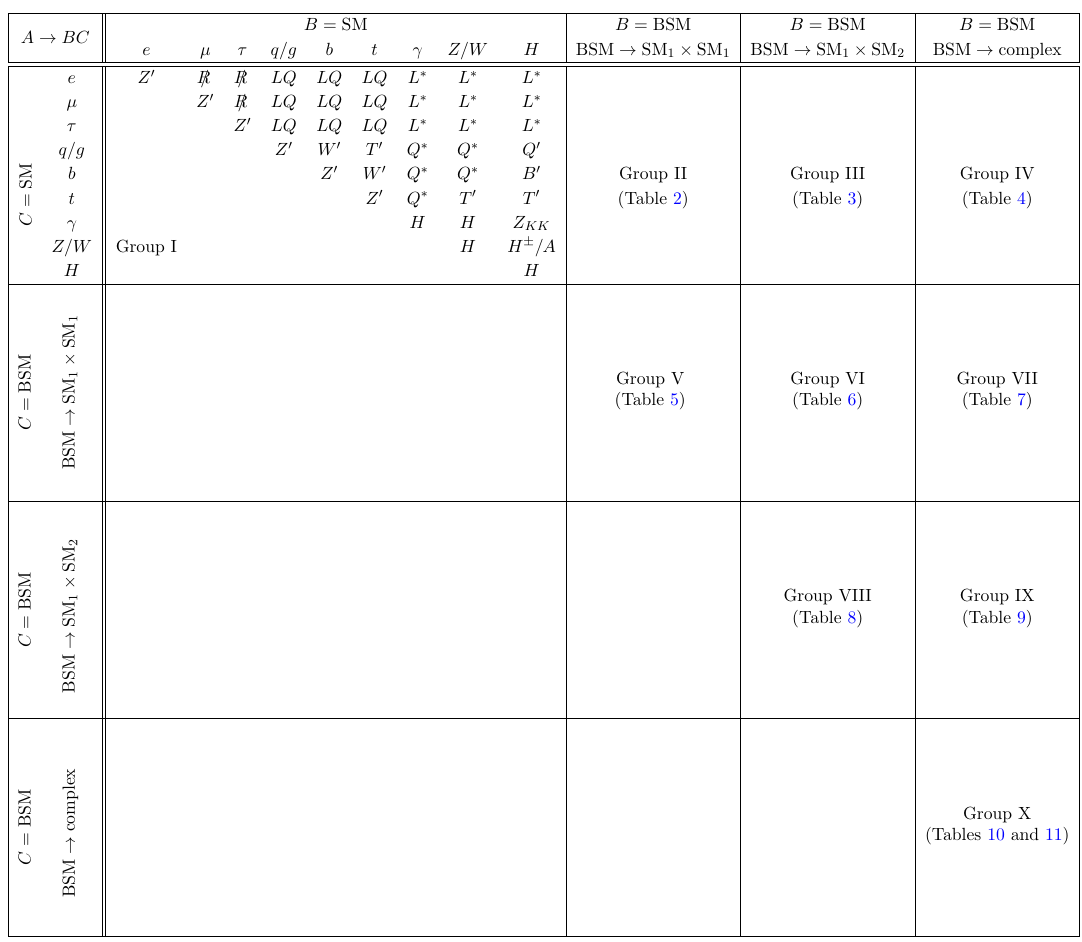
Table 1 . Top-level organization of BSM particle A by its two-body decays into B and C , showing examples of theoretical motivations for each case. Z 0 and W 0 denote additional gauge bosons, =R represents R -parity violating SUSY, L (cid:3) ; Q (cid:3) are excited leptons and quarks, respectively, and T 0 and B 0 are a vector-like top and bottom quarks, respectively. The symbol Z KK denotes Kaluza-Klein excitation of SM Z . The SM case in the upper left box is reproduced from ref.